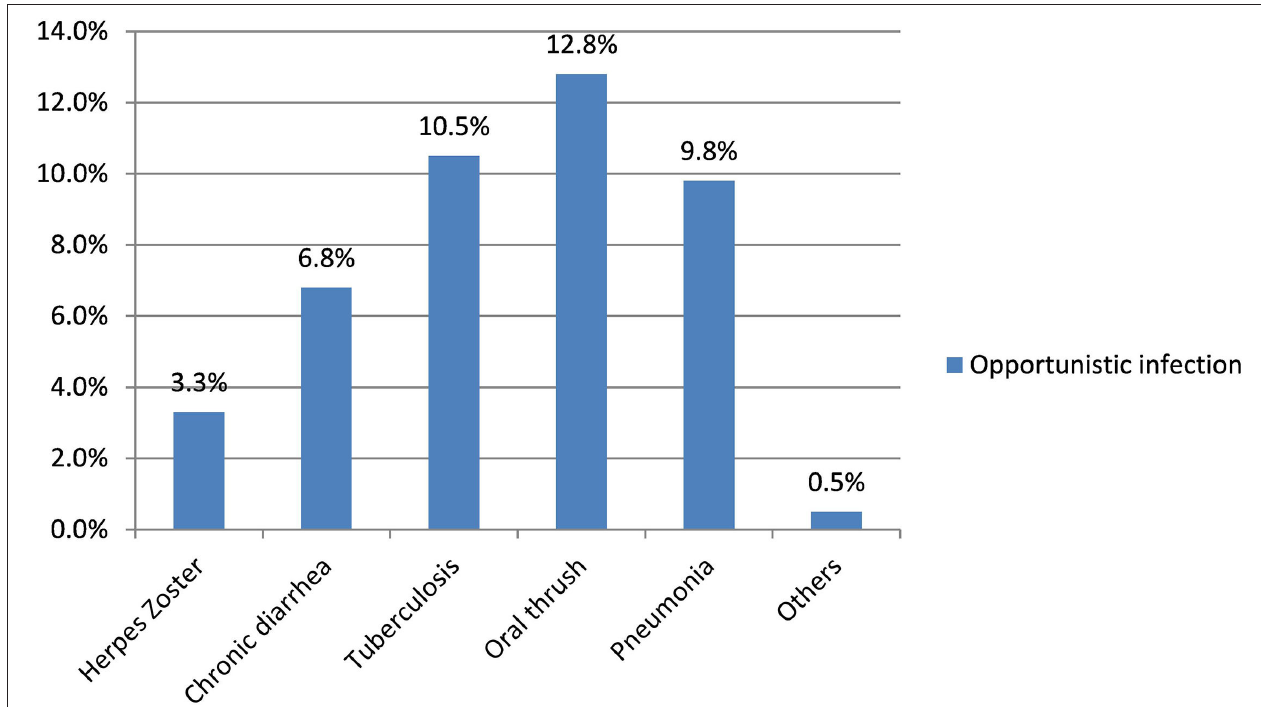
FIGURE 1 | Depression, anxiety, co-occuring anxiety and depression based on sex of the respondents among PLHA at government health institution in Bihar Dar, 2016.